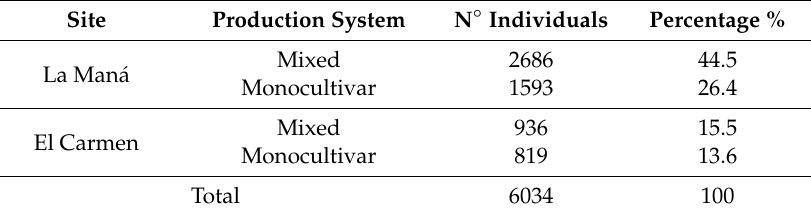
Table 5. Number of individuals registered in each type of production system at both sampling sites in 2014.